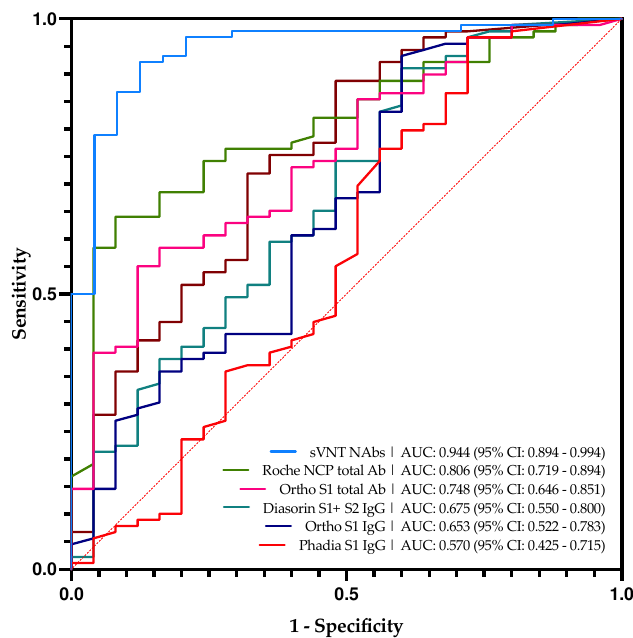
Figure 2. Roc curve analyses of all serological tests in this study and sVNT technique in comparison with pVNT based on the manufacturer’s cut-offs.